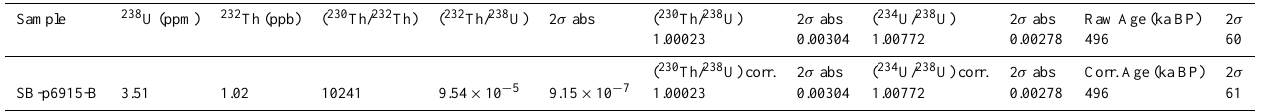
Table 1. U-Th dating results for the SB-6915-B stalactite layer (Vaks et al., 2013). The corrected values are shown in the 3rd and 4th rows.